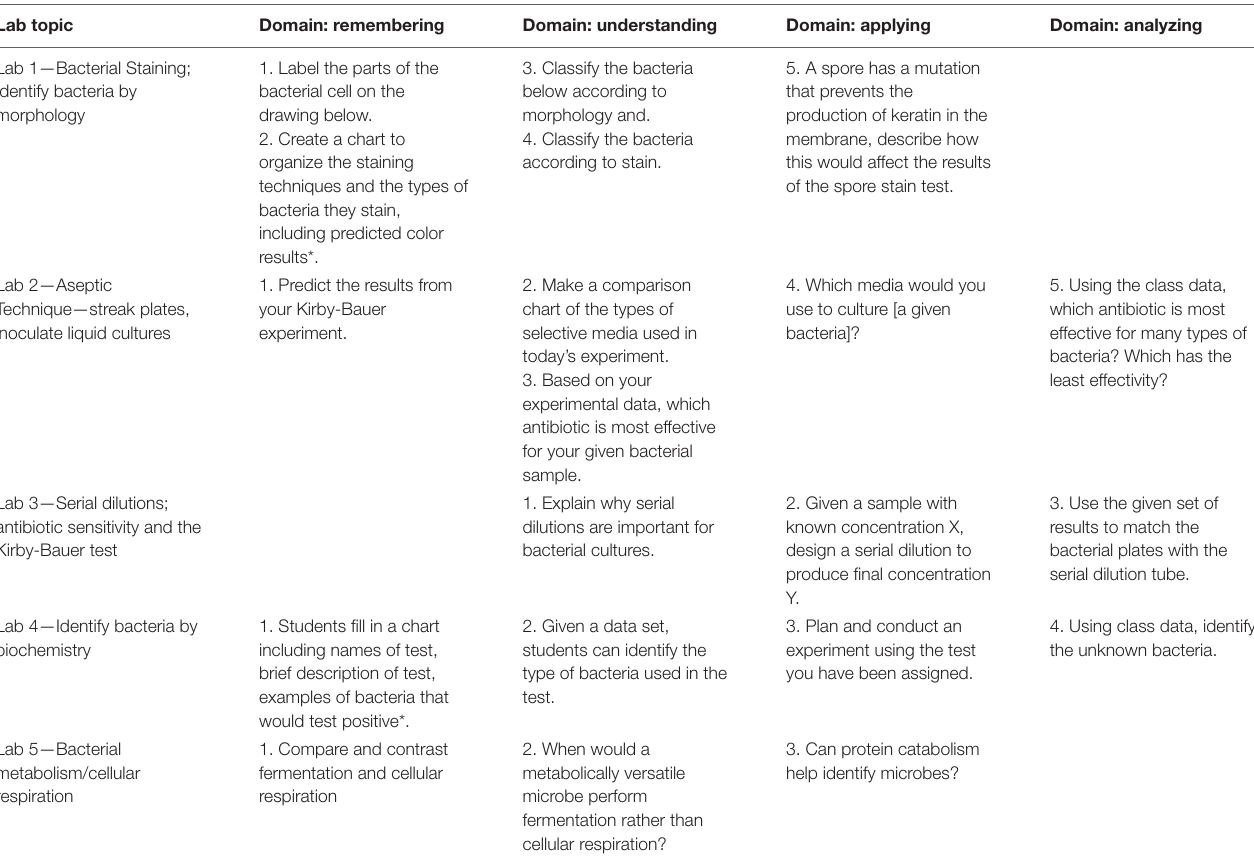
TABLE 3 | Post-lab Thought Questions were deployed using adaptive learning software after each introductory and CURE